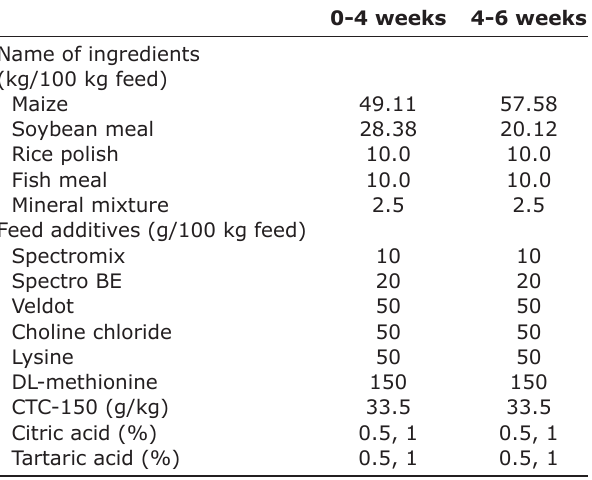
Table-2: Ingredient composition of experimental diets.